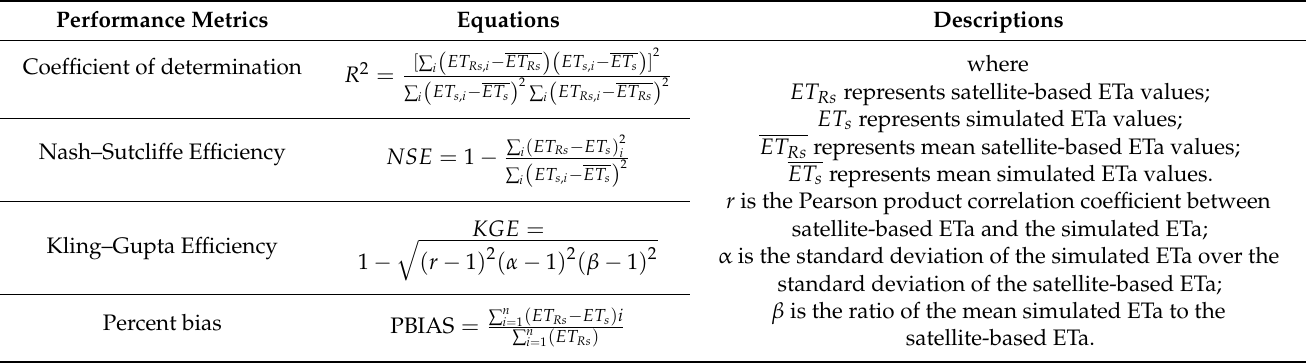
Table 6. Metrics used to evaluate the calibration and